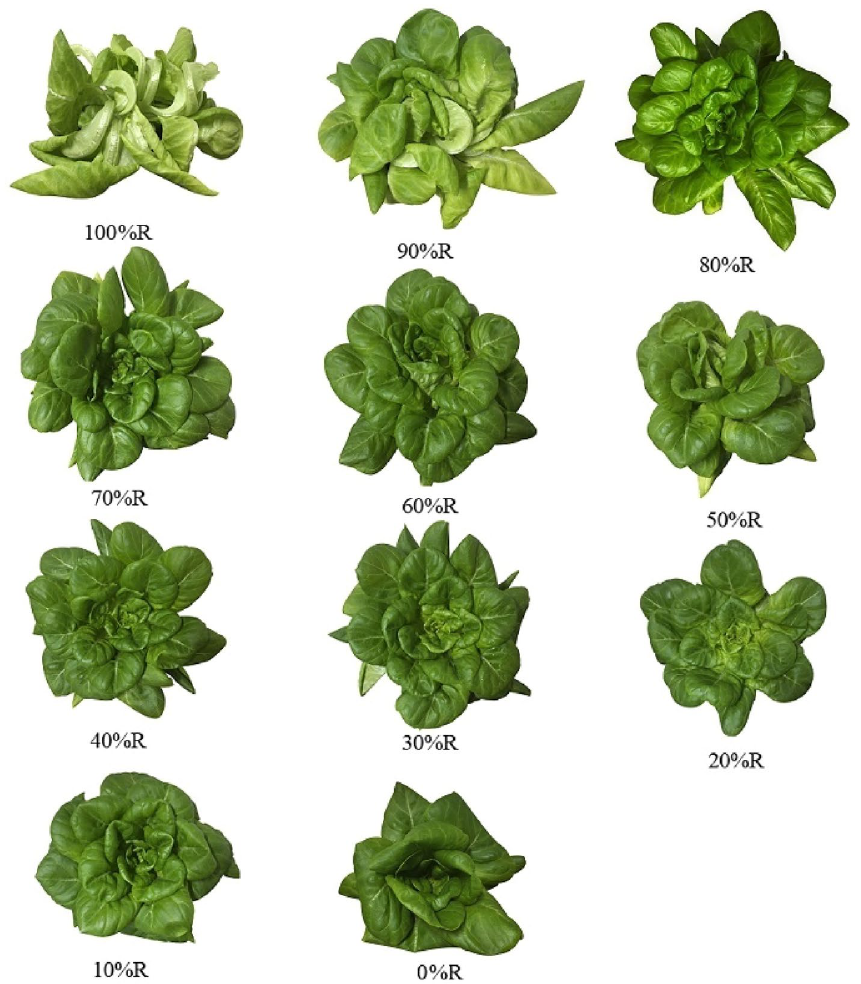
Figure 2. Morphology of lettuce under different light treatments at harvest (49DAS). (The URL link of the software used in the figure is http:// adobe. com/ cn/ produ cts/ photo shop.